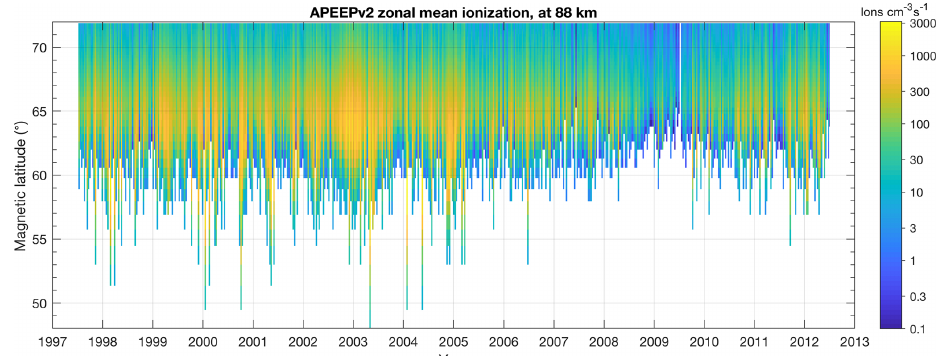
Figure 1. Ionization rates from the APEEPv2 model. The daily data have been averaged into 10d resolution for clarity. The white areas indicate no data and correspond to satellite flux measurements that were screened for being below the noise floor. Tick marks on the x axis are in the middle of each year.